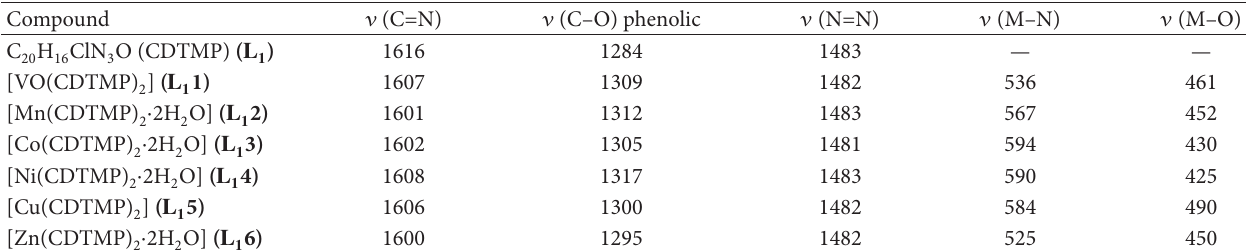
T 2: IR spectral data of [CDTMP] and its metal(II) complexes (cm